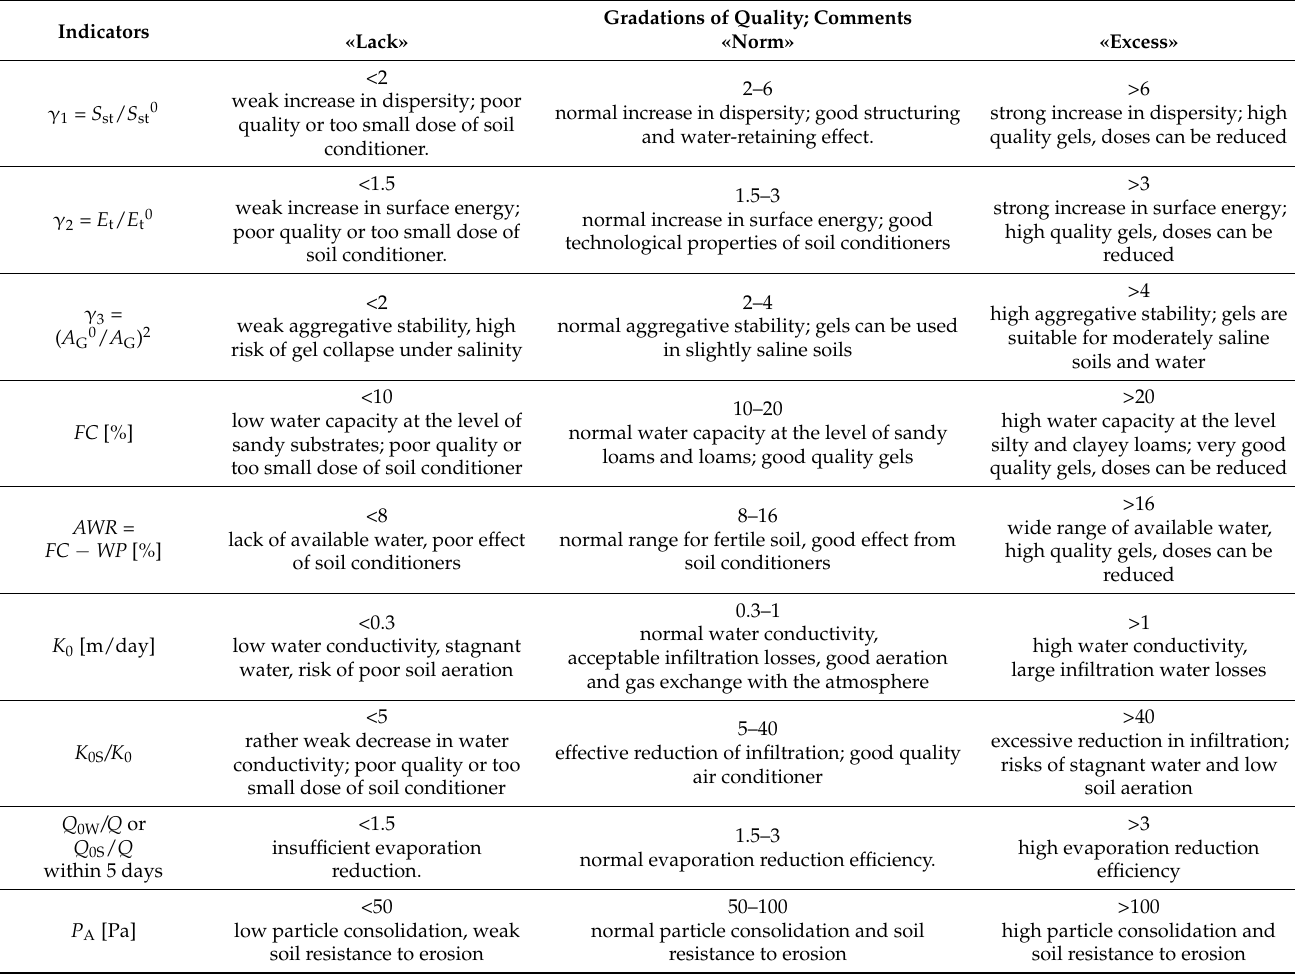
Table 3. Guidelines for the main quality indicators of gel compositions with coarse-textured soil substrates (doses range of hydrogels